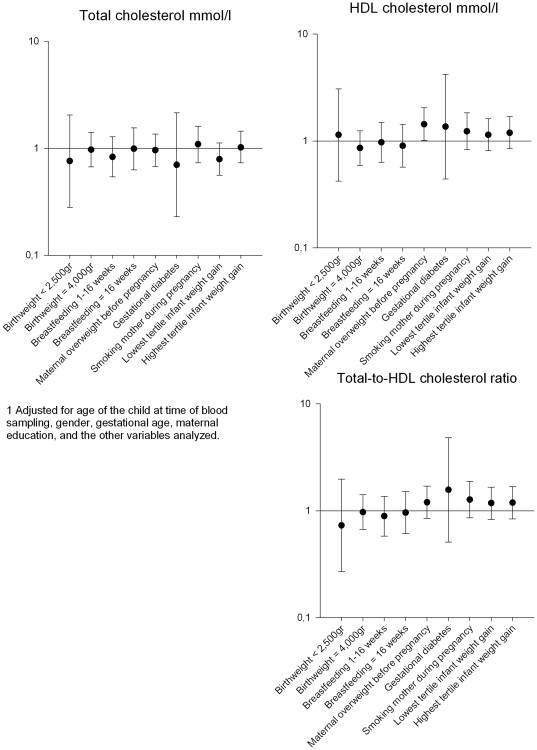
Adjusted1 odds ratios with 95% confidence intervals.